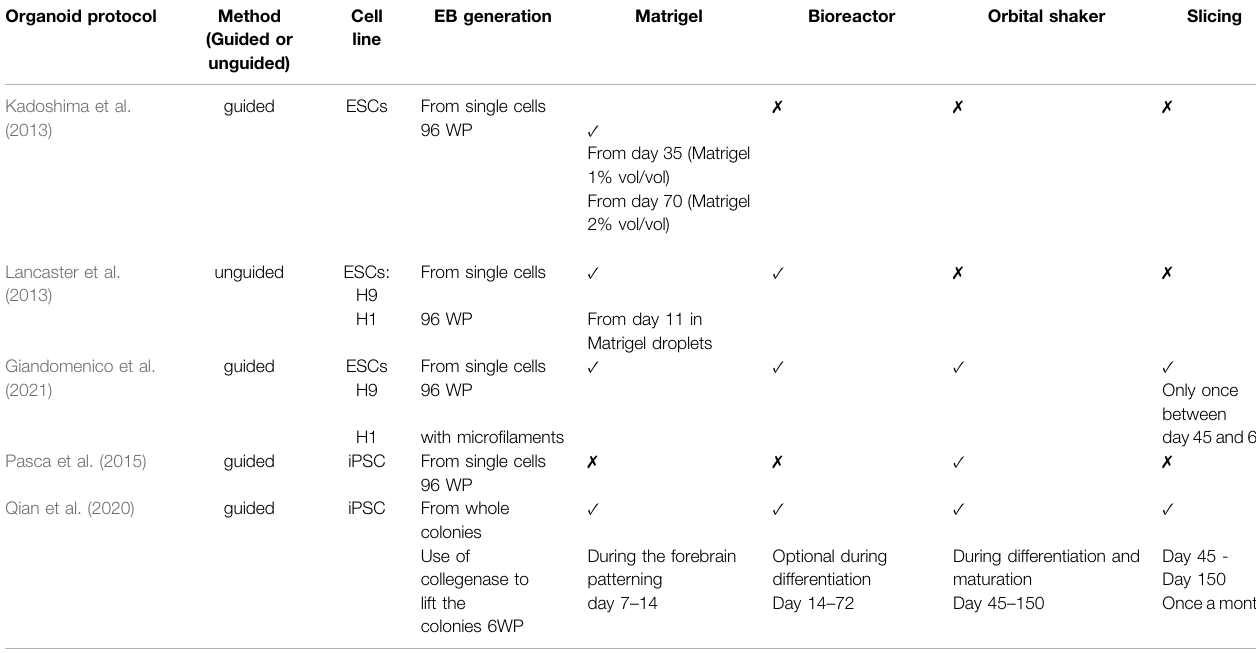
TABLE 1 | Brain organoid protocols. Organoid